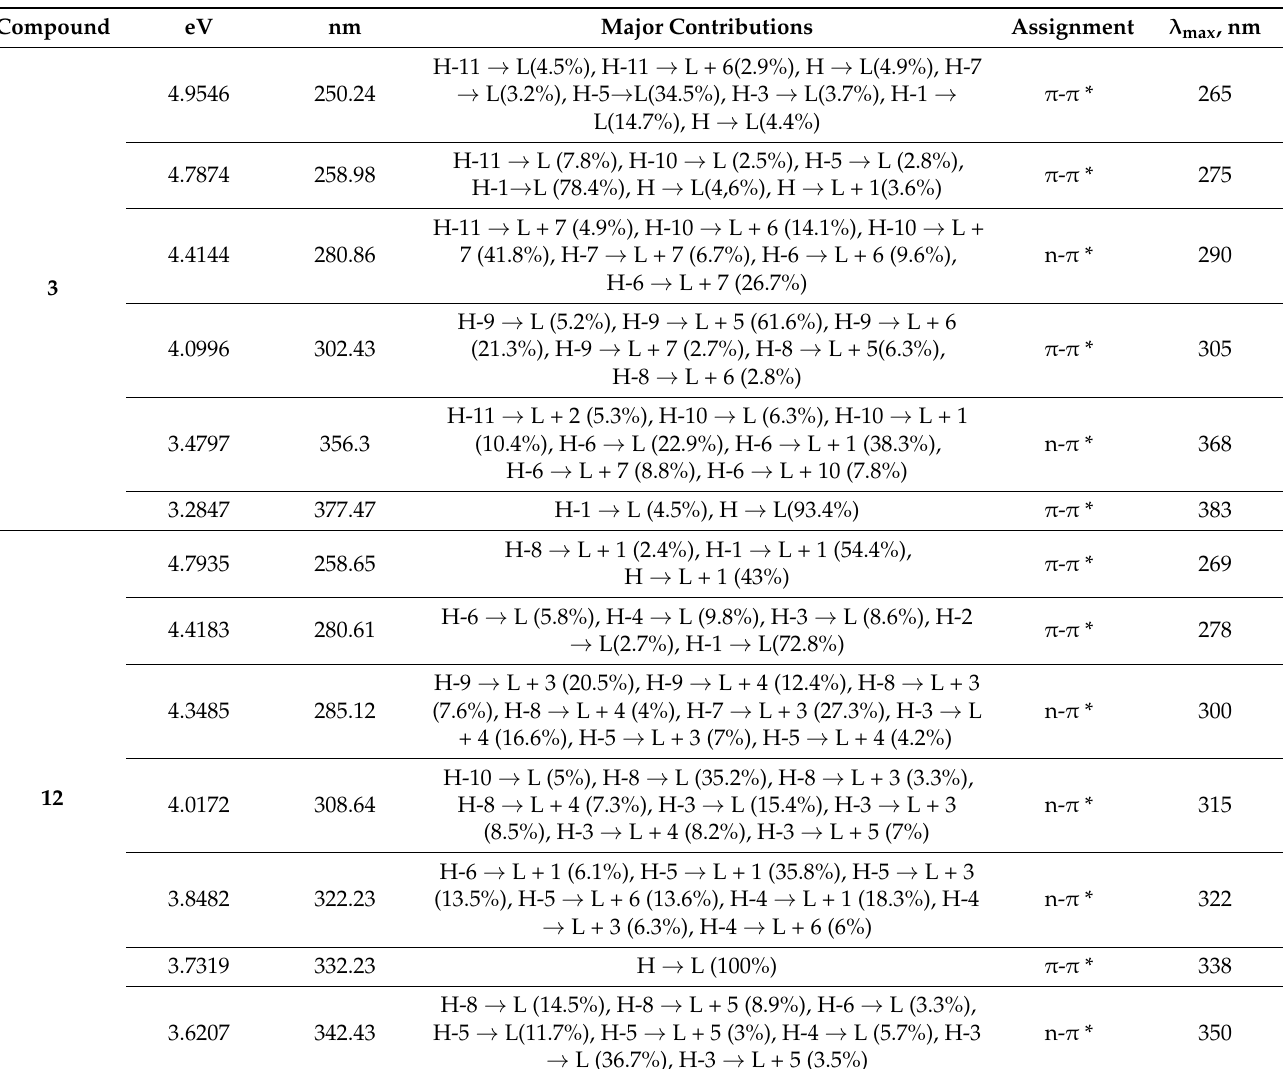
Table 8. Computed excitation energies (eV), electronic transition configurations and wave lengths (nm) of the obtained stable compounds; 3 and 12 by using B3LYP/Cep-31G for the, (f ≥ 0.001) f = oscillator strengths compared with experimental data of UV-Visible spectra, λ max ,